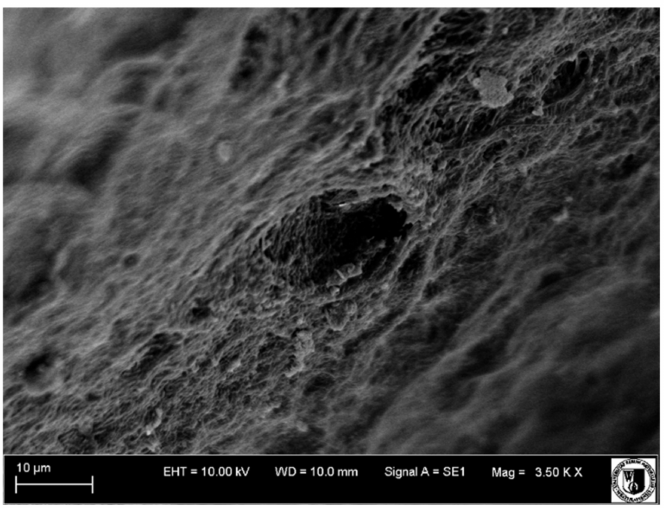
Figure 22. Scanning electron microscope image, human molar—Group IV. Minor vessel in the dental pulp (arrow). 3500 ×